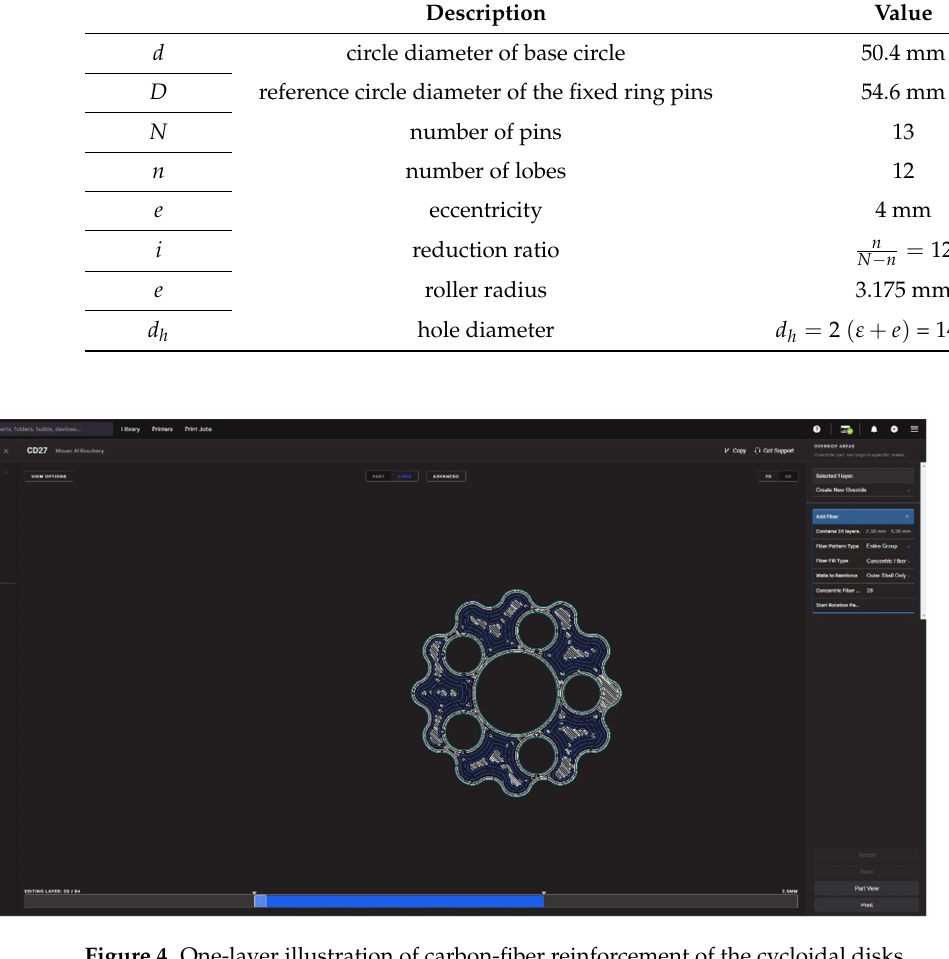
Figure 4. One-layer illustration of carbon-fiber reinforcement of the cycloidal disks. To link the output shaft to the four-bar linkage input point, a timing belt with a 4:1 reduction ratio is used; the maximum input torque to the four-bar mechanism should be slightly more than 39